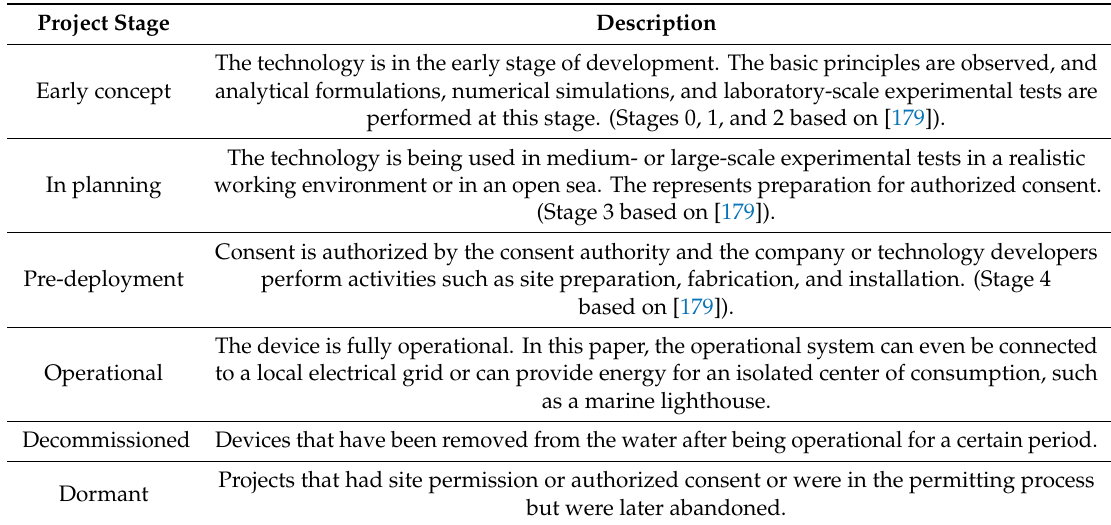
Table 2. Stages of ocean renewable energy project